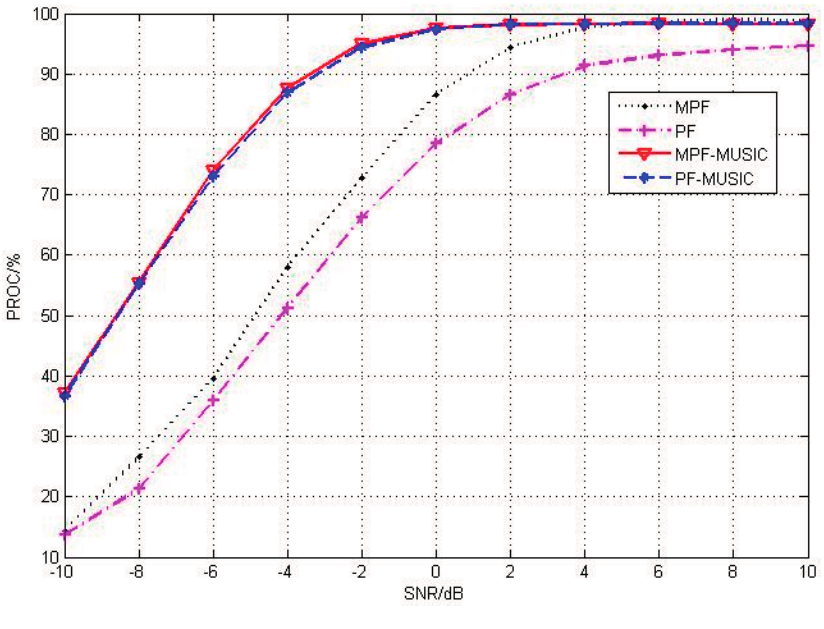
Figure 3. PROC with different SNRs.